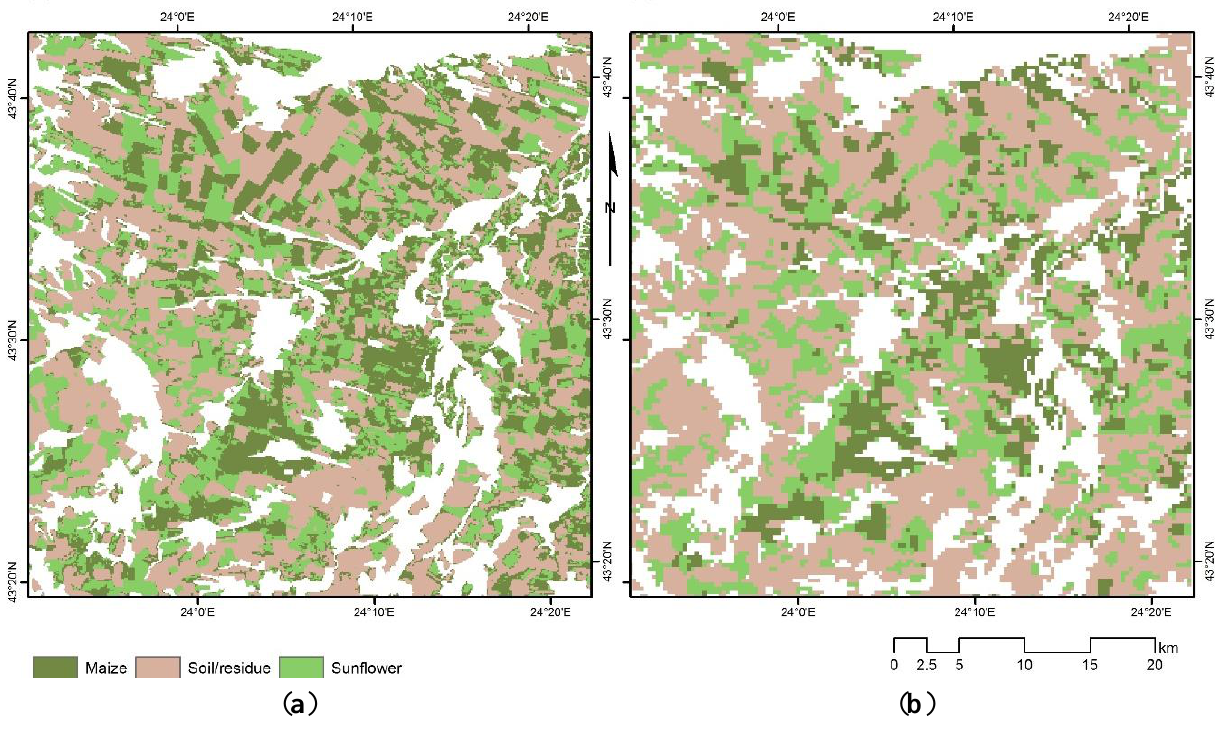
Figure 3. Classification results using PROBA-V 100 m ( a ) and 300 m ( b ) multi-spectral images from 8 July 2014 (SINGLE4 experiment) for mapping maize and sunflower. Note that areas outside the CORINE class 211 (agriculture) were left